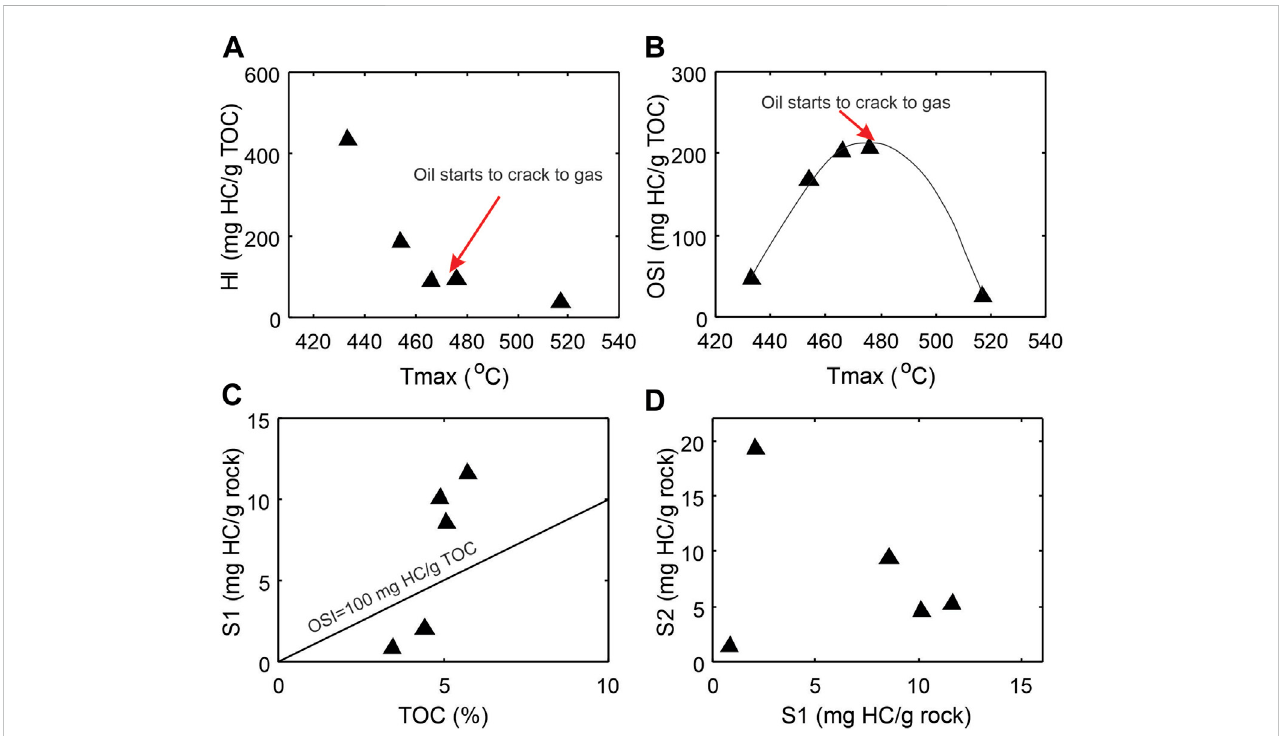
FIGURE 4 Cross-plots of Rock-Eval parameters showing general characteristics of the source rock samples and the thermal maturity overprints. (A) Hydrocarbon generating potential hydrogenindexHI vsmaturityparameterTmax; (B) Oilsaturation indexOSI vsmaturity Tmax; (C) S1peak vsTOC; (D) S2 peak vsS1peak. OSI=S1/TOC × 100 (oil saturation